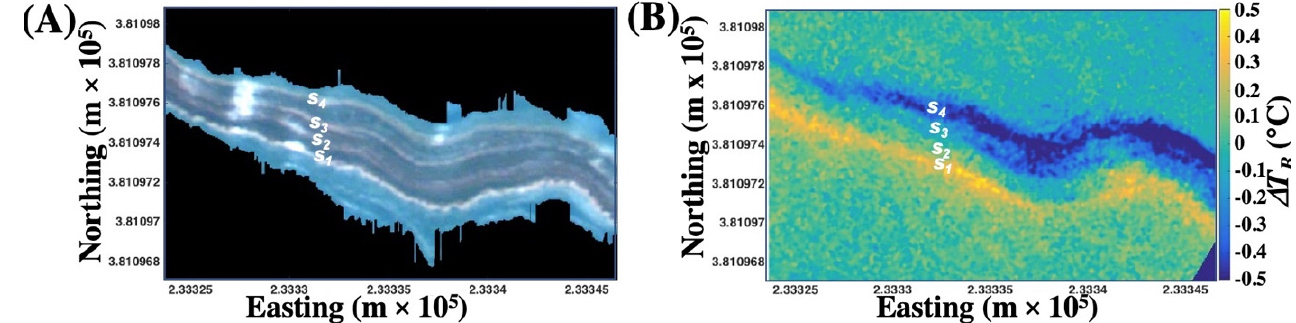
Figure 8. Focus area ( A ) Visible slick image and ( B ) Thermal brightness contrast, Δ T B . Streamer internal slicks labeled. Scene location shown by white arrow in Figure 7A. Data keys on panels imagery acquired 23 May 2016.